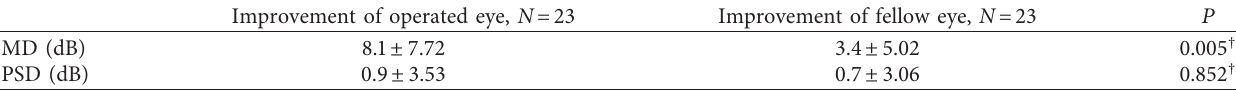
Table 5: Improvement of visual field parameters of the operated eyes and fellow eyes after treatment in patients with bilateral DON.